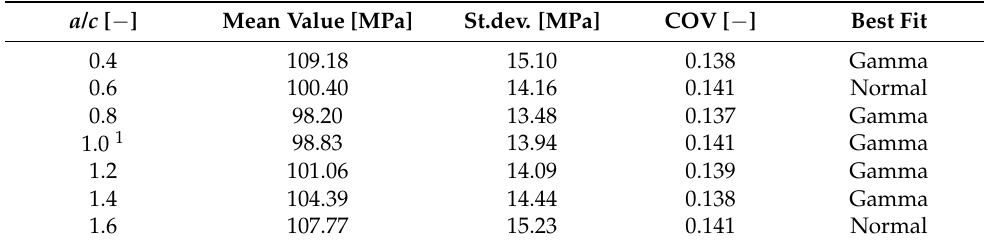
Table 8. Data for a varying flaw